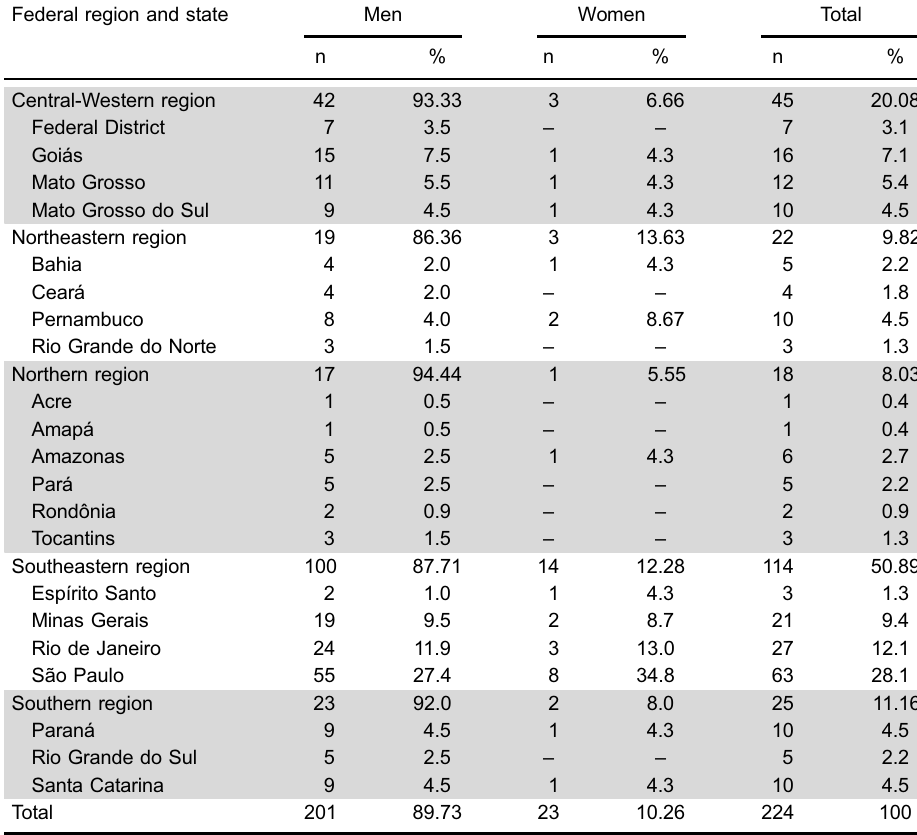
Table 2. Medical lawsuits per Brazilian region and federal state. Federal region and